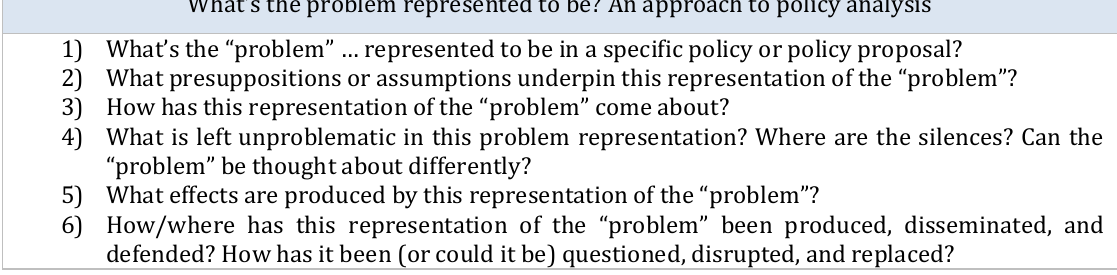
Table 1: Bacchi’s (2009) “What’s the Problem Represented to Be?”